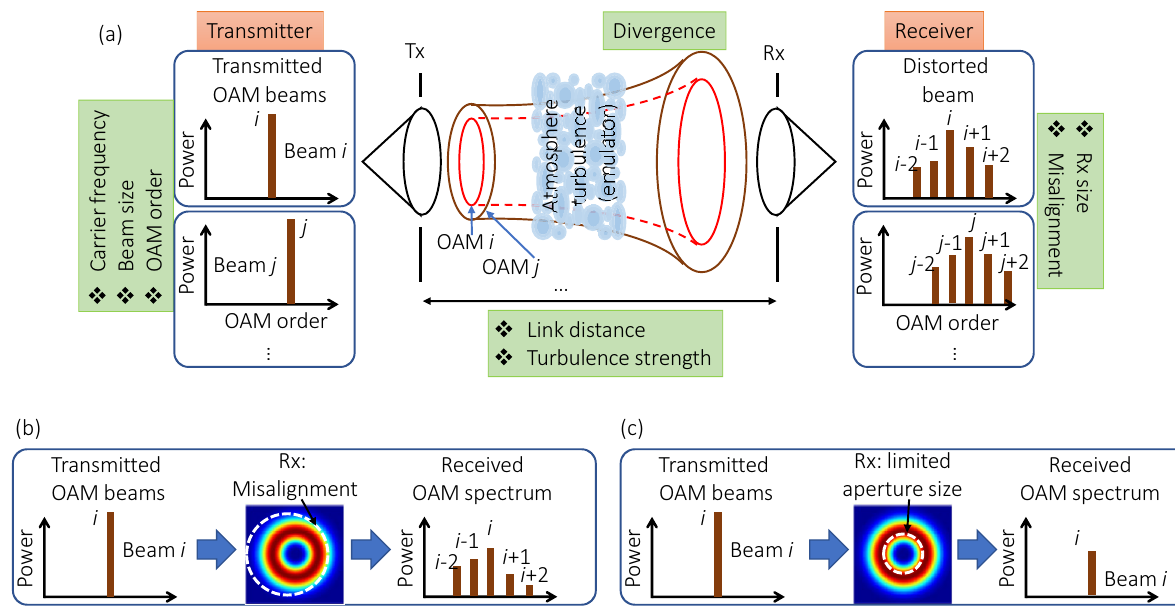
Figure 1. Schematic of a THz communication link using OAM multiplexing. ( a ) Propagation of an OAM beam through turbulence leads to the distortion of its phasefront. At the receiver side, such a beam evolves to a beam with both distorted amplitude and phase profiles. ( b , c ) A receiver with limited aperture size and misalignment could further degrade the system performance. Tx transmitter, Rx